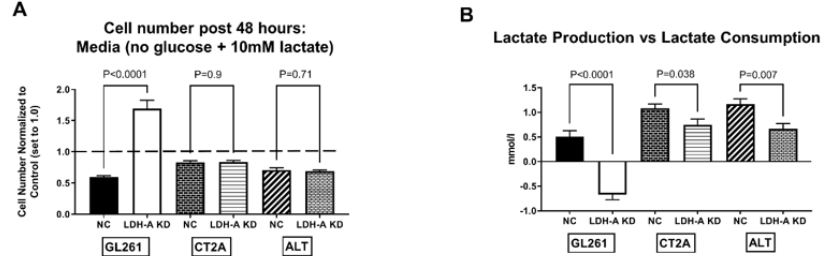
Figure 5. Effect of Na-lactate on the proliferation and the production vs. consumption of lactate in LDH-A KD vs. control NC glioma cell lines. Effect of adding 10 mM Na-lactate to the culture media containing 0 mM Glucose on the 48 h proliferation of GL261, CT2A and ALTS1C1 murine glioma cell lines (comparing LDH-A KD to the NC control; 6 cell lines) ( A ). The control measure of prolif- eration (cell number after 48 h of incubation) in the absence of both lactate and glucose is set to 1.0, (dashed line); the experiment addresses whether Na-lactate alone can support cell proliferation ( A ). Lactate concentration was measured in the culture media before and after the 48 h incubation ( B ); the starting lactate concentration (0 h) was subtracted from the final concentration (48 h), and the difference is plotted ( B ). A positive value indicates “lactate production”, whereas a negative value indicates “lactate consumption” ( B ). Values are mean, ±SEM; n = 3.